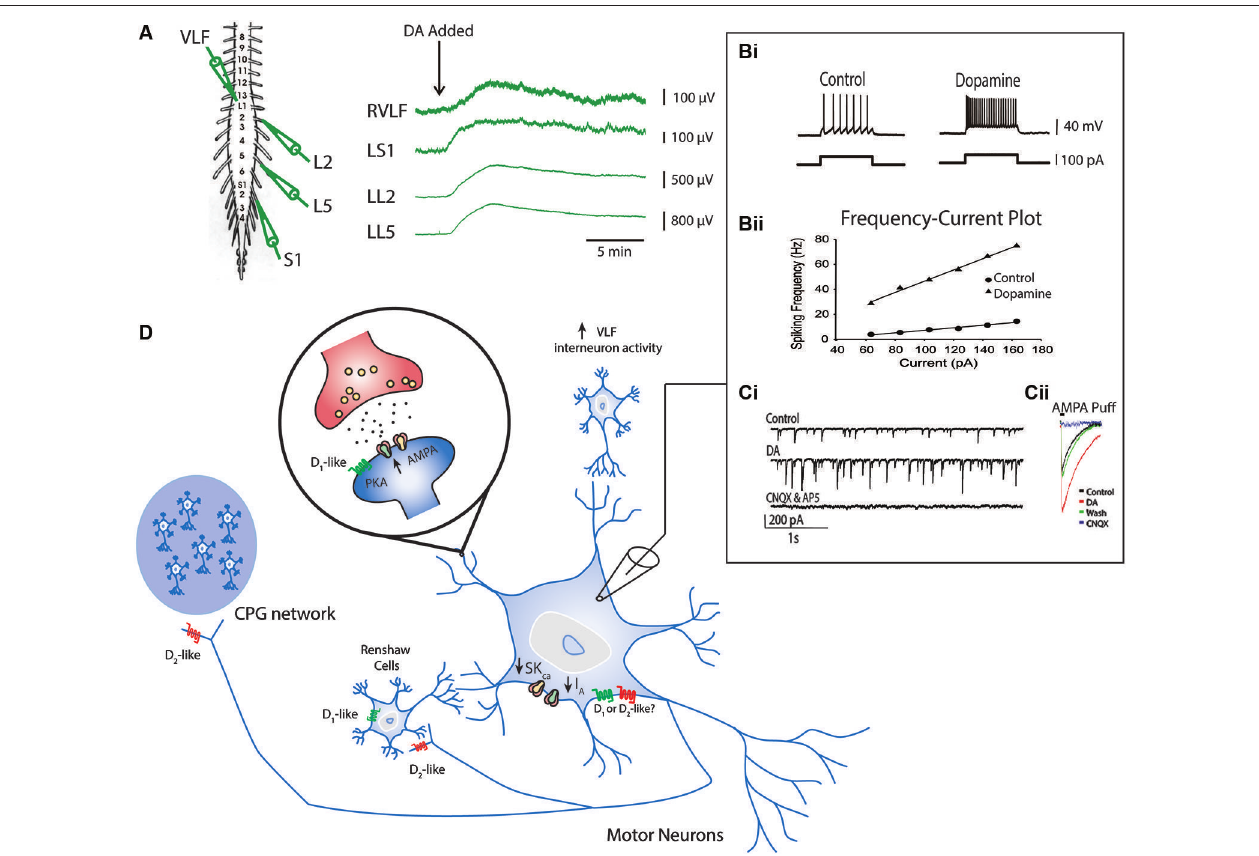
indicated by an increase in the slope of the frequency-current relationship (Bi and Bii) . This effect is in part mediated by a reduction in I A and SK Ca conductances. Dopamine also increases AMPA conductances (Ci and Cii) via a D 1 -like receptor mechanisms (Adapted with permission from Han and Whelan, 2009). Dopamine reduces recurrent excitatory feedback to the locomotor CPG (Humphreys and Whelan, 2012) and Renshaw cells via D 2 -like receptor mechanisms (Maitra et al., 1993). A summary of all these effects are depicted in panel (D)